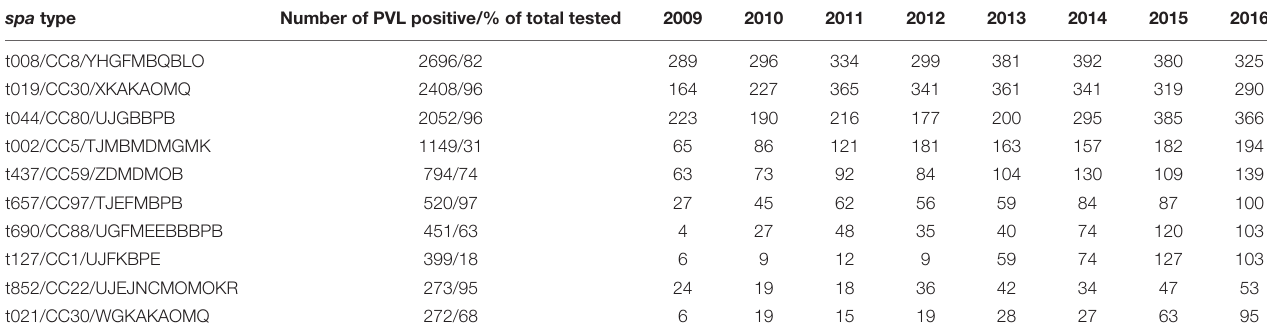
TABLE 4 | The ten most prevalent PVL positive MRSA spa types in the Nordic countries 2009-2016 in total and by year. spa type Number of PVL positive/% of total